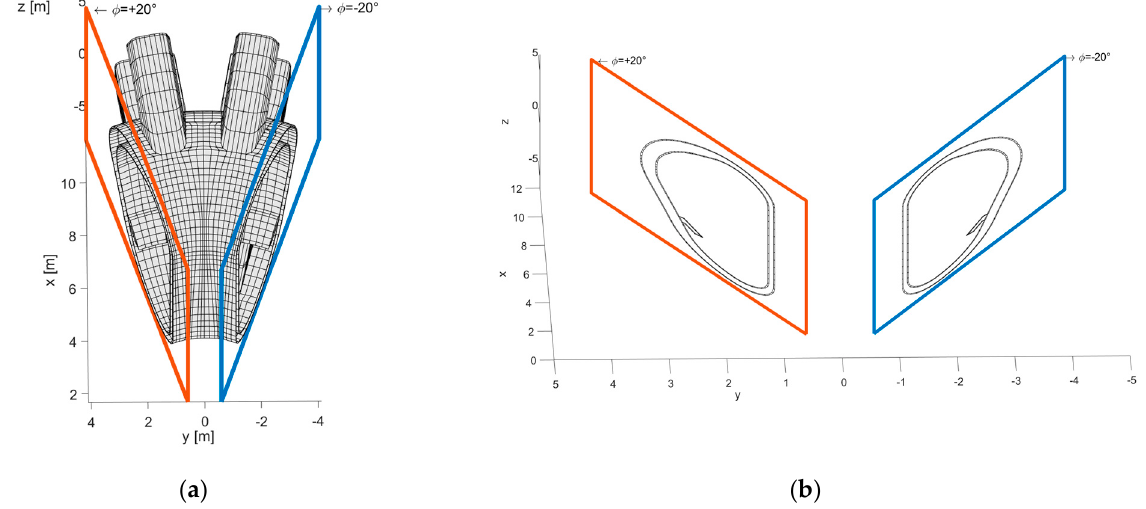
Figure 2. Forcing periodic boundary conditions. ( a ) The sector mesh ( −20° < φ < 20° ); ( b ) The boundary faces at φ = −20° and φ = +20 °. The current flowing at each face at φ = −20° should be equal to the current flowing in the correspondent face at φ = +20°.